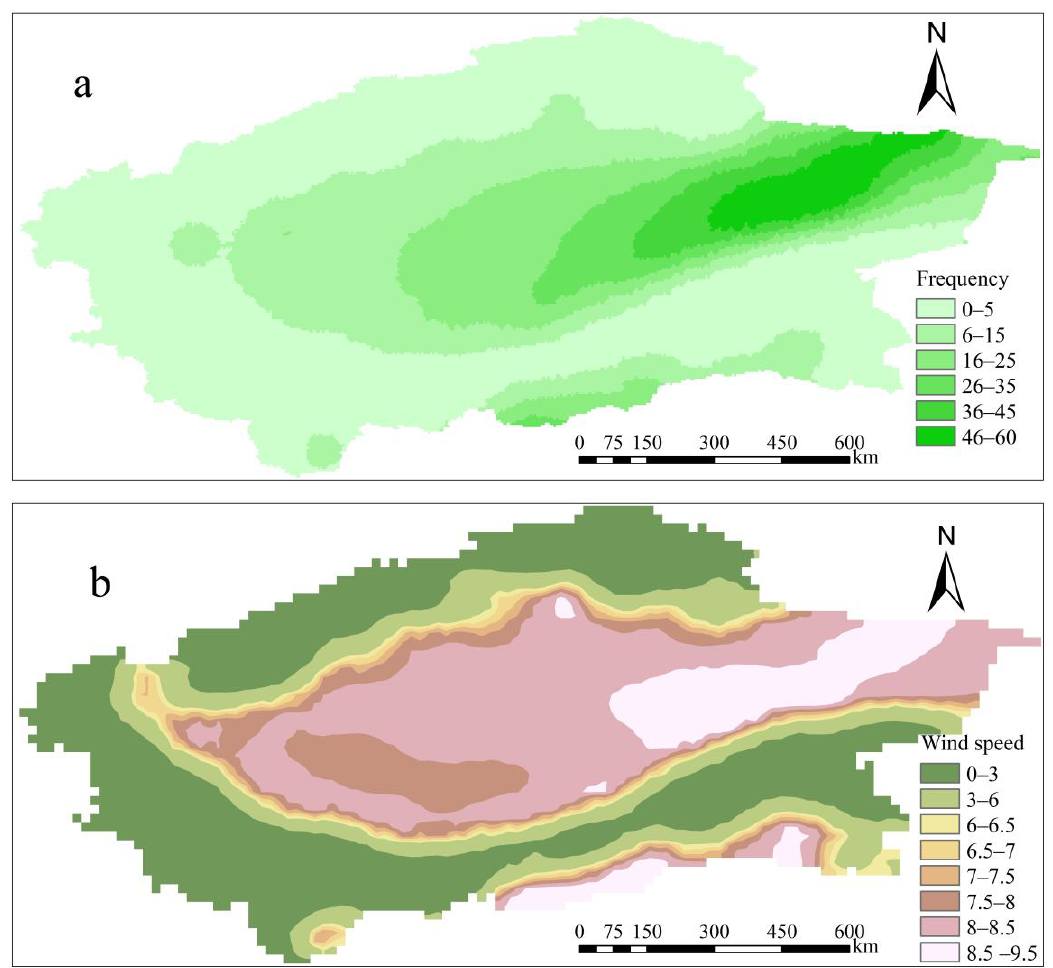
Figure 10. (a) Gale weather frequency; (b) Annual average wind speed in gale weather. Figure 10. ( a ) Gale weather frequency; ( b ) Annual average wind speed in gale